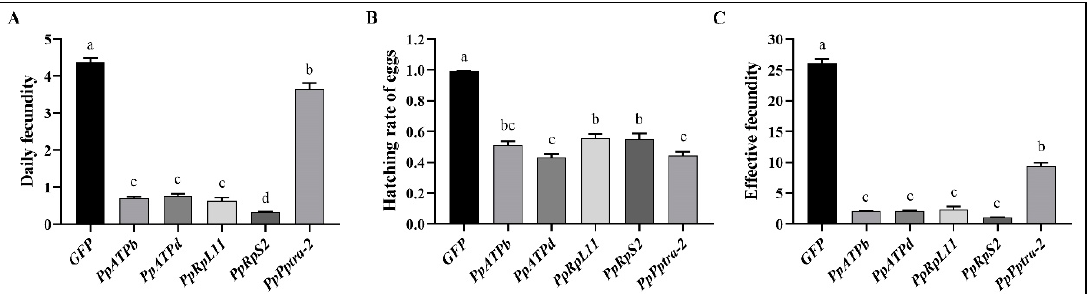
Figure 3. Reproductive capabilities of P. persimilis when the five genes were interfered. ( A ). Daily fecundity per female. ( B ) Egg hatching rate. ( C ) Effective fecundity per female. Letters above each bar (Means ± SEM) indicate significant differences across each treatment (SNK tests: p < 0.05).